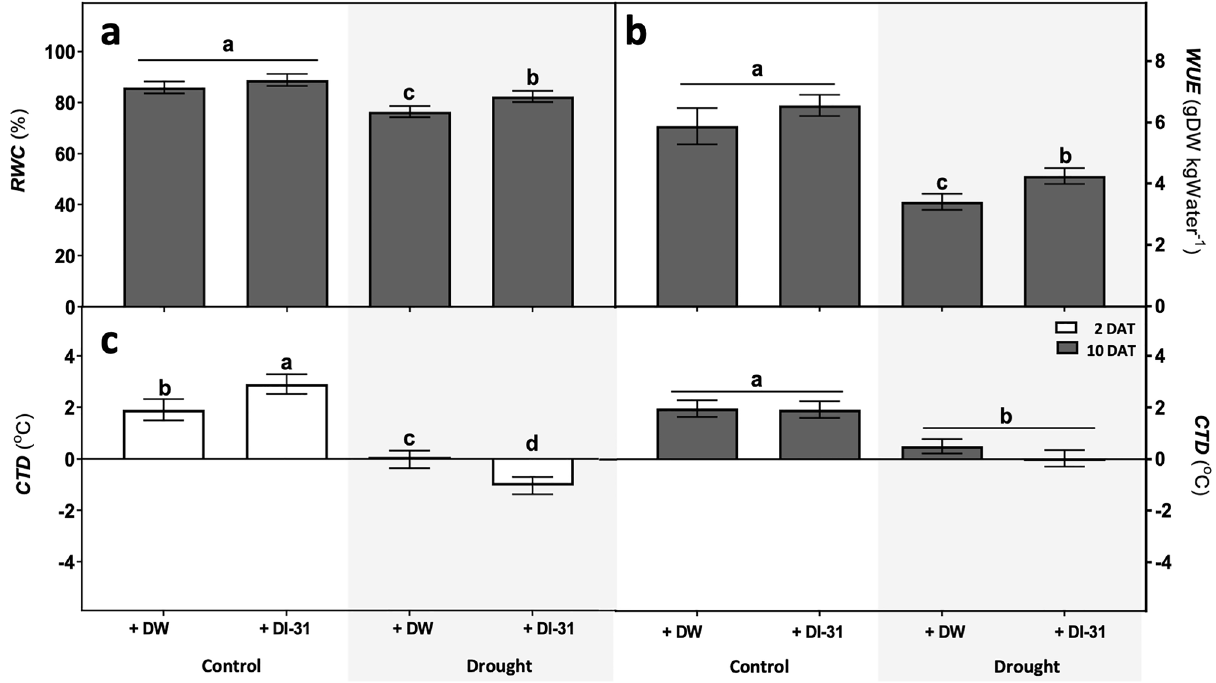
Figure 2. Effect of distilled water (DW) and DI-31 (2.23 µM) foliar applications in soybean water relations. Parameters such as ( a ) relative water content (RWC), ( b ) water use efficiency (WUE), and ( c ) canopy temperature depression (CTD) were measured in cv Munasqa plants submitted to well-watered (Ψs = − 0.05 MPa) and drought (Ψs = − 0.65 MPa) conditions. Colour bars indicate parameters assessed after two (white) or ten days (grey) of stress and foliar treatments. Data are presented in means ± s.e.m of two independent experiments (n = 200). Different letters indicate significant differences ( P ≤ 0.05) ANOVA with post hoc contrasts by Tukey’s